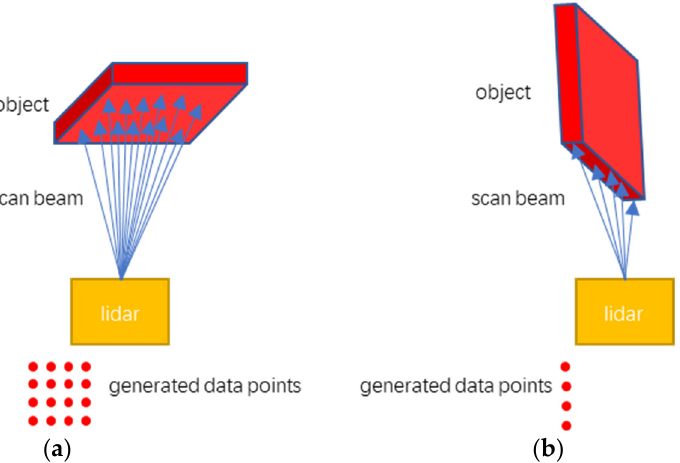
Figure 9. The relationship between object posture and point cloud density. Figure ( a ) shows the situation where the larger surface of the object points to the lidar; figure ( b ) shows the situation where the smaller surface of the object points to the lidar.